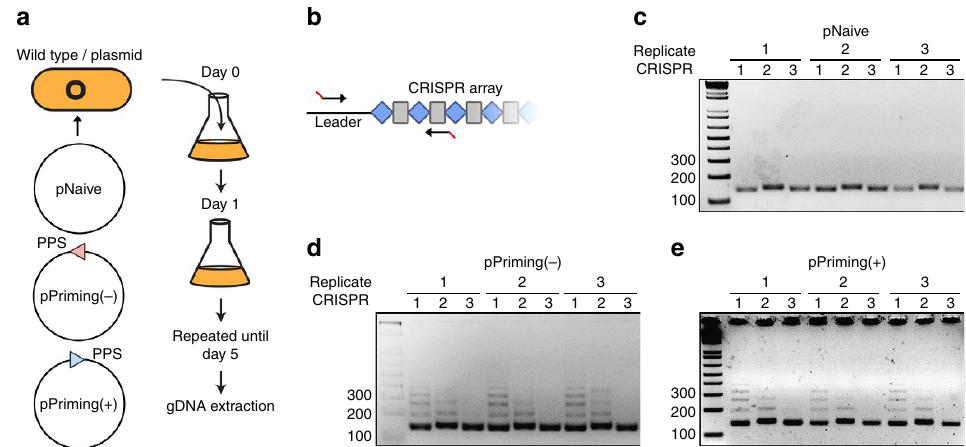
Figure 1 | Schematic of the high-throughput spacer acquisition assay. ( a ) Genomic DNA was extracted from wild-type P. atrosepticum cells containing plasmids without a protospacer, pNaive, or with a protospacer on either the minus, pPriming( (cid:2) ), or plus strand, pPriming( þ ), after passaging for 5 days. ( b – e ) CRISPR arrays were amplified by PCR and analysed on 3% agarose gels.